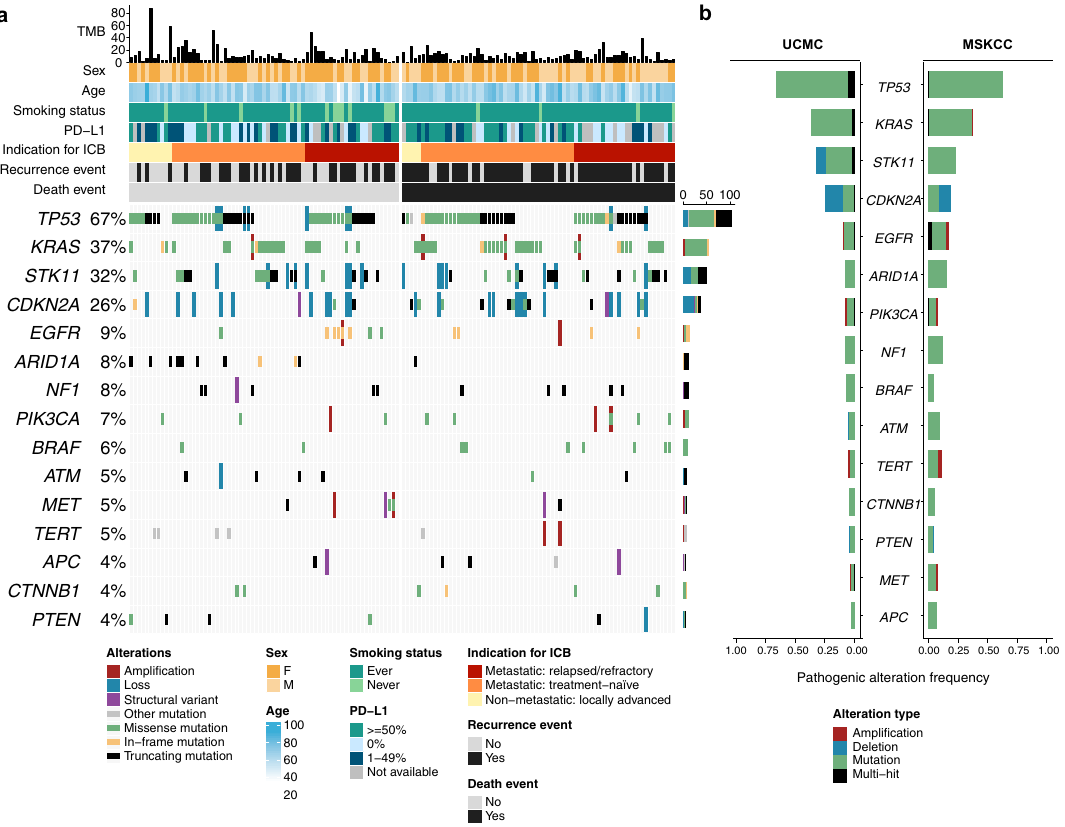
Figure 1. Genomic landscape of NSCLC tumors. ( a ) OncoPrint plot of UCMC cohort demonstrating top 15 recurrently altered genes. TMB, tumor mutational burden (mutations per megabase). PD-L1, Programmed death ligand-1. ICB, immune checkpoint blockade. OncoPrint plots were generated using the ComplexHeatmap package in R. ( b ) Frequencies of most commonly altered genes in UCMC and Memorial-Sloan Kettering Cancer Center (MSKCC)